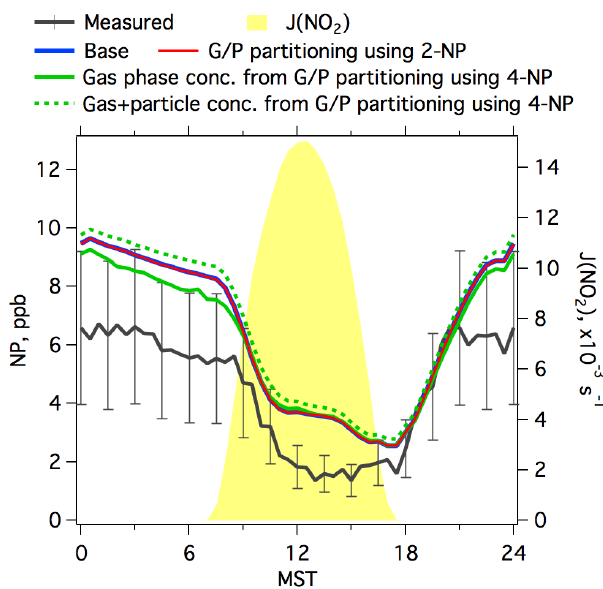
Figure 6. Diurnal profiles of measured and modeled concentrations of NP from the base simulation and the simulations considering gas–particle partitioning. Photolysis frequencies of NO 2 are shown for reference. Error bars indicate the accuracies of measured con- centrations of NP